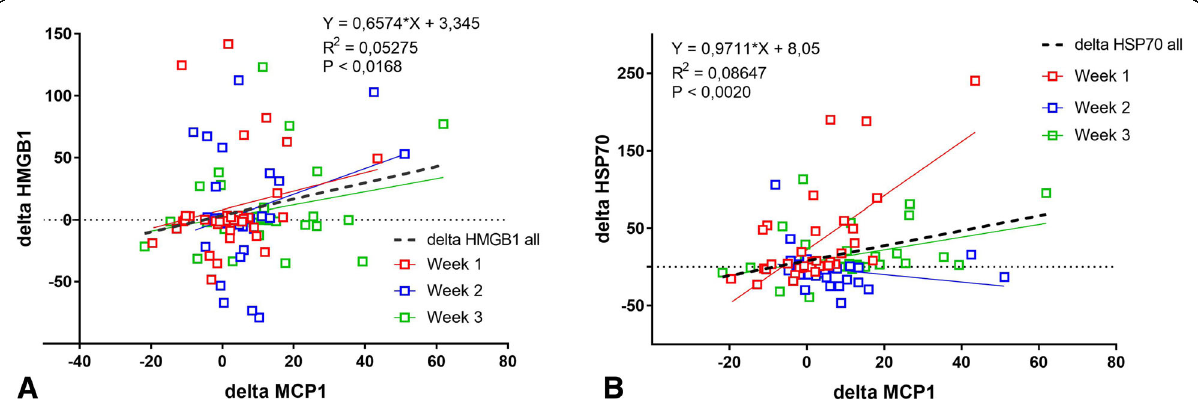
Fig. 9 Relationship of Δ HMGB1 and Δ HSP70 with Δ MCP-1 during 3 weeks of exercise training. Linear regression plots demonstrating Δ HMGB1 ( a ) and Δ HSP70 ( b ) relative to Δ MCP1 during 3 weeks of exercise